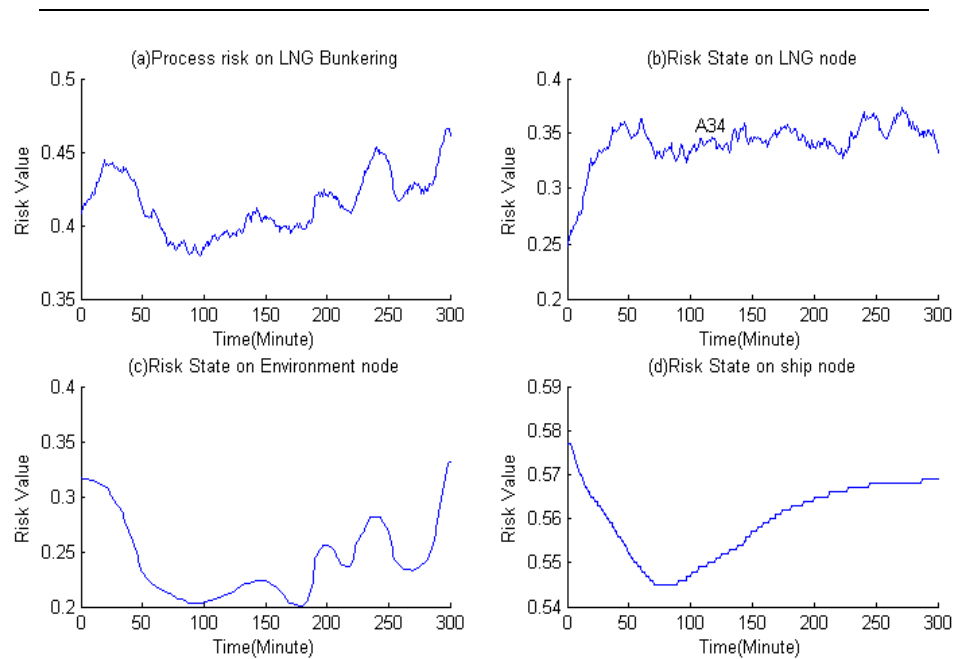
Figure 7. Safety level graph on the flange of the connecting pipeline was damaged during the fueling. ( a ) Process risk on LNG Bunkering. ( b ) Risk State on LNG node. ( c ) Risk State on Environment node. ( d ) Risk State on ship node.